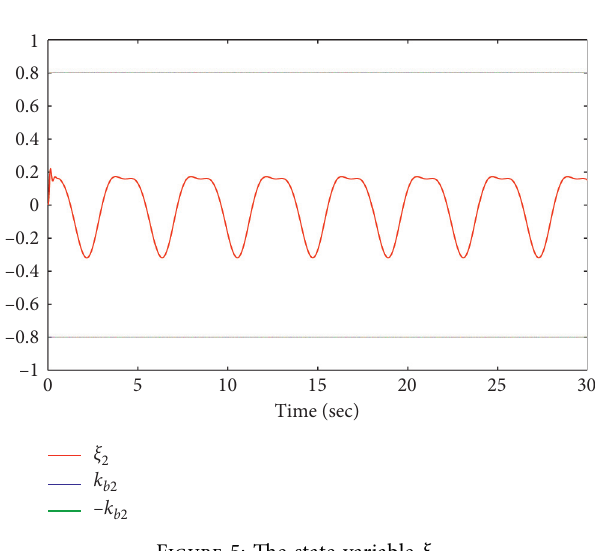
Figure 5: The state variable ξ